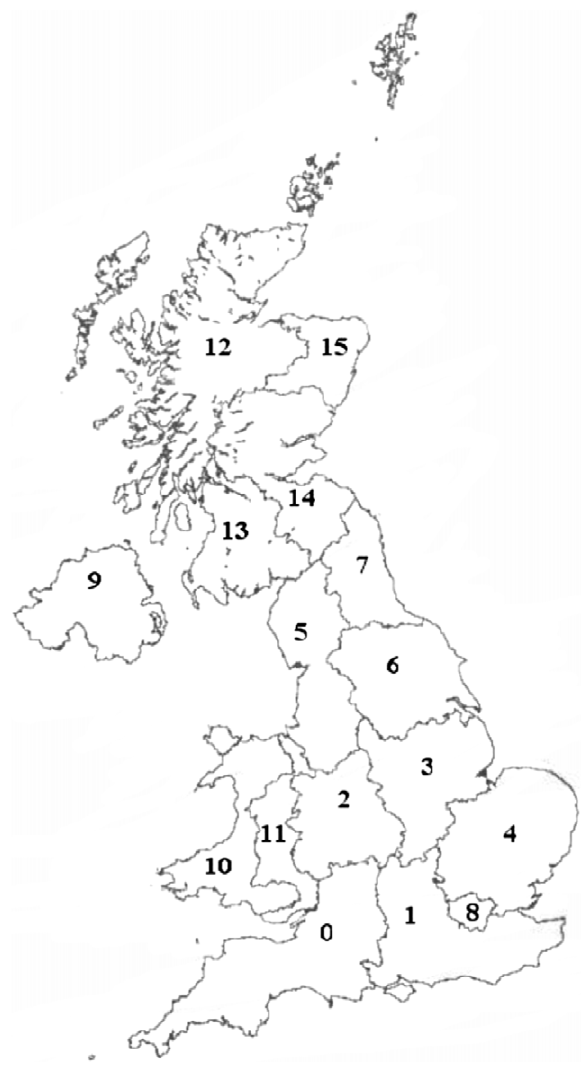
Figure 2. The regions of the UK used in comparing past and future risk. Region details are shown in Table 1.